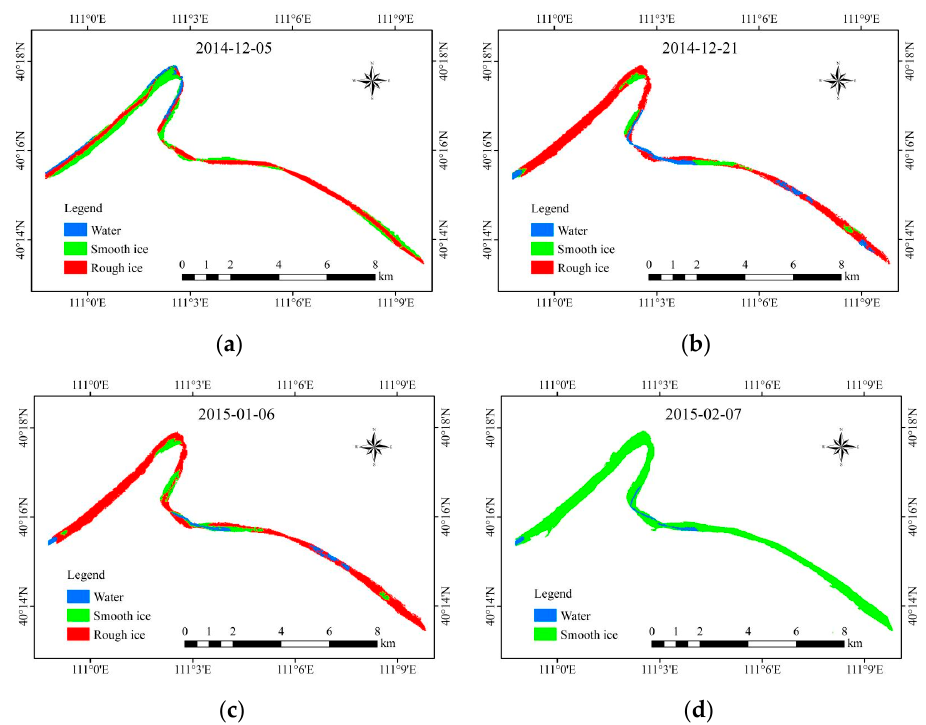
Figure 5. The Landsat remote sensing interpretation results of the Shensifenzi bend in ( a ) 5 De- cember 2014, ( b ) 21 December 2014, ( c ) 6 January 2015, and ( d ) 7 February 2015. 2014, ( c ) 6 January 2015, and ( d ) 7 February